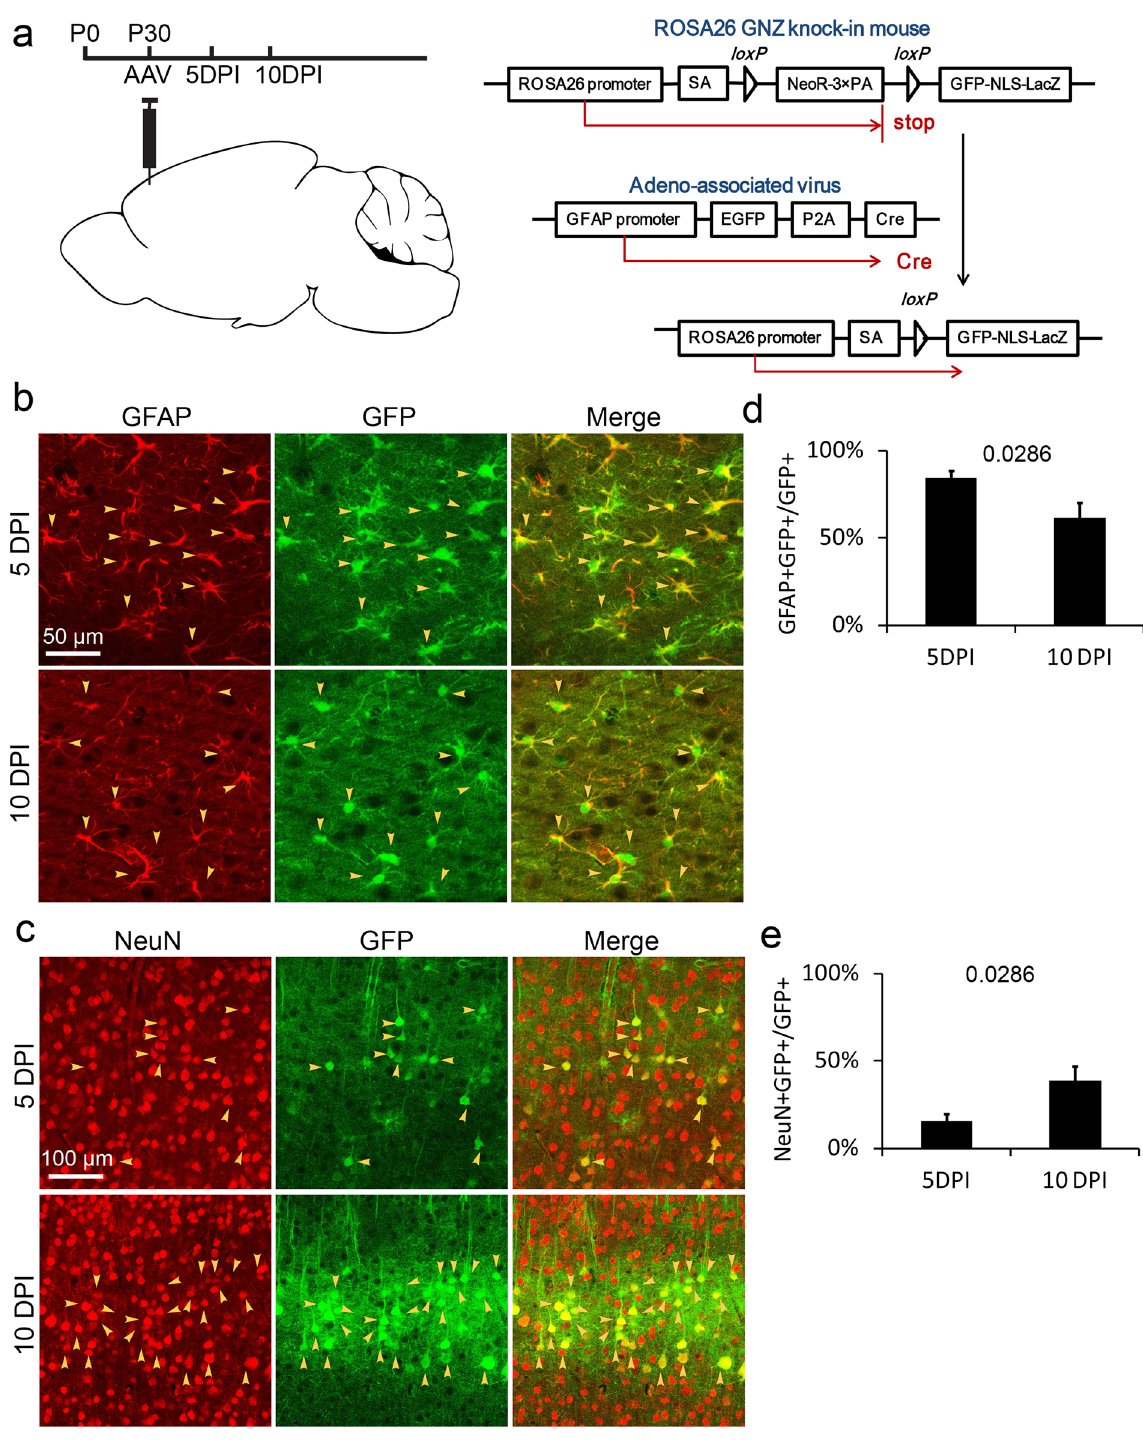
Figure 1. The existence of EGFP in the cortex. ( a ) Schematic illustration of stereotaxic injection of AAV- GFAP - EGFP-P2A-Cre in mouse cortex and the cre-loxP system in ROSA26 GNZ mice. AAV, Adeno-associated virus; 5 DPI, 5 days post injection of AAV; 10 DPI, 10 days post injection of AAV. ( b ) and ( c ) Detection of EGFP distribution in astrocytes of layer I–III and neurons of layer V 5 days and 10 days after injecting AAV. Yellow arrows, double positive cells. ( d ) and ( e ) The percentage of astrocytes and neurons in EGFP+ population at 5 DPI and 10 DPI. DPI, days post injection. Statistical analysis of significance was evaluated using unpaired two- tailed t-test, N = 3 independent